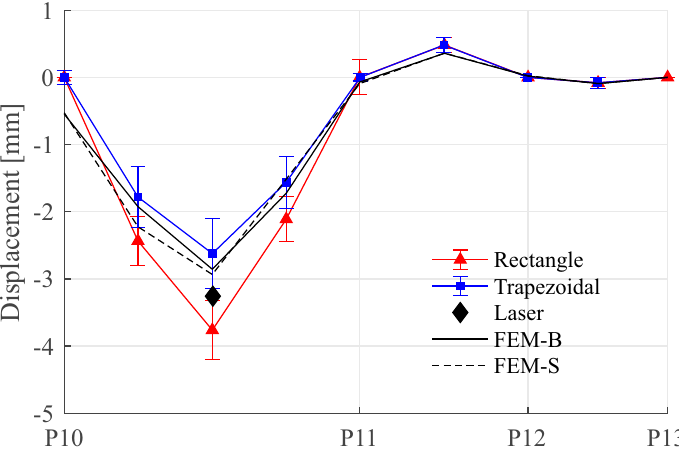
Figure 11. Comparison between experimental and numerical displacements.